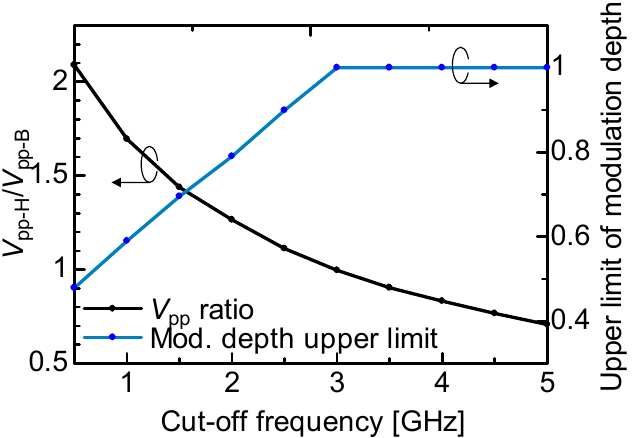
Figure 11. Driving signals peak-to-peak voltage ( V pp ) ratio and the modulation depth’s upper limit of the high-pass Hilbert transformer based OSSB-SC signal. PAPR and optical bandwidth of the modulator output signal are plotted against the cut-off frequency and presented in Figure 12. Peak reduction of Hilbert-transformed signal results reduced PAPR of the modulator output signal. PAPR reaches unity around the cut-off frequency of 3 GHz.